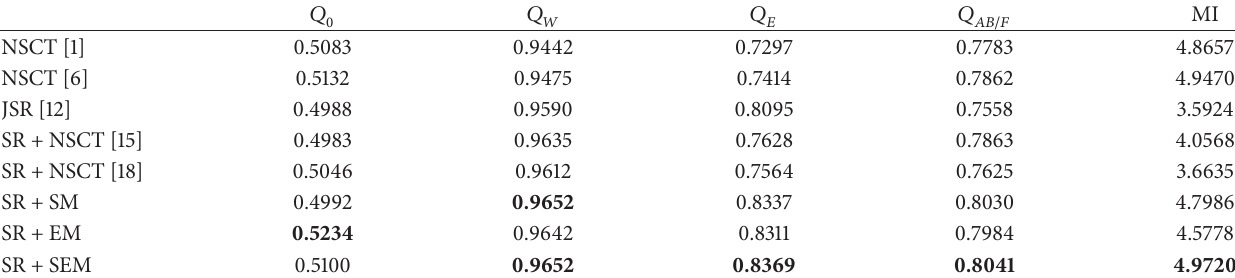
Table 3: The objective evaluation and running time for CT and PET image fused results of all